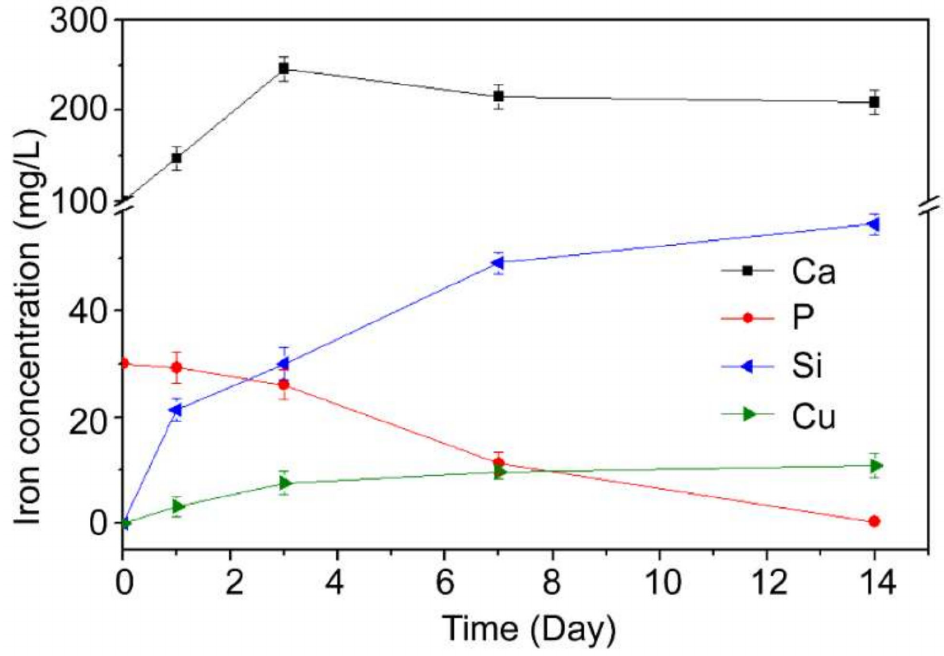
Figure 5. The changes of ion concentrations after 40% CuBG/PEEK (CP40) soaking in SBF solution for different amounts of time (means ± SD, n =